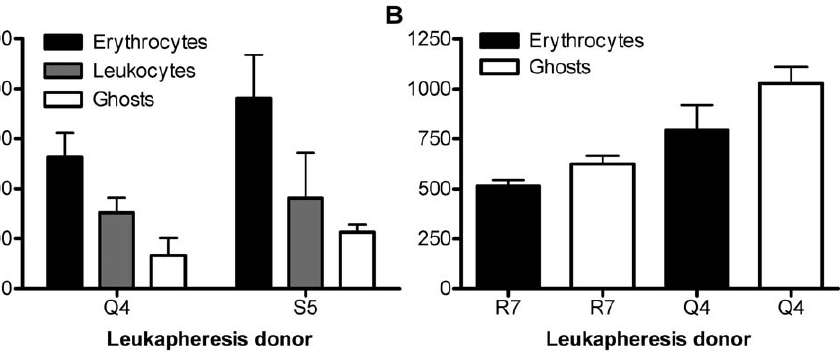
Figure 3. HIV-1 binds to erythrocytes, erythrocytic ghosts, and leukocytes. (A) After incubation of 151,286 pg of HIV isolate 89BZ_167 with the indicated preparation containing 2.5 6 10 9 erythrocytes, the mean p24 bound ( 6 SD of triplicate measurements) was determined. The erythrocytes were then hemolyzed and the p24 bound to the ghosts and the leukocytes was separately measured. (B) After incubation of 105,900 pg of HIV-1 isolate 89BZ_167 with the indicated erythrocyte preparation (3.5 6 10 9 erythrocytes), or with purified ghosts previously depleted of leukocytes, from each donor, the mean bound p24 ( 6 SD of triplicate measurements) was determined.